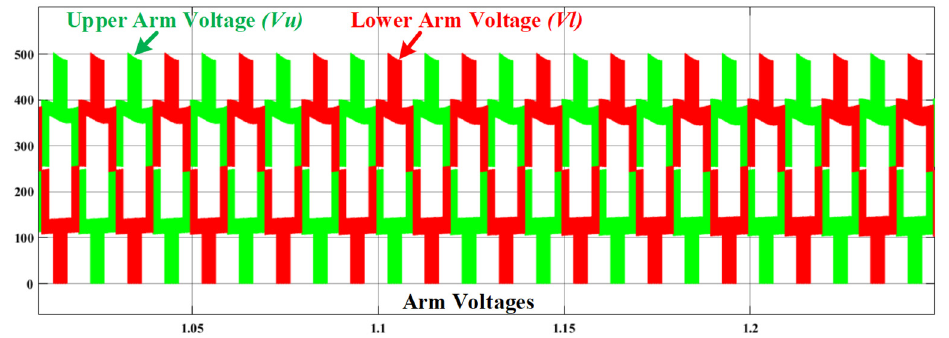
Figure 6. Simulation result for arms’ voltages of phase (cid:1853) ((cid:1848) (cid:3048) , (cid:1848) (cid:3039) ) in MMC.